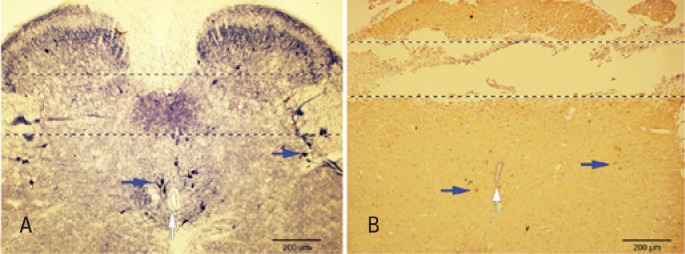
(A). Microphotography of a transversal cryostatic section (40μM) of the spinal cord segment (L6-S1) showing NADPH-diaphorase-positive neurons (blue arrows) and neuropil. Discontinued lines show the site where where the probe was located in the experiments in which the interstice tissue was microdialyzed. It can be noted that the probe position is approximately 200μM dorsally to the central canal (white arrow). (B). Microphotography of a transverse section (6μM) obtained from a paraffin-embedded spinal cord segment (L6-S1) showing positive nNOS immunoreactive neurons (blue arrows) and fibers as well as the tunnel left by the microdialysis probe. Note that the tunnel is approximately 200μM dorsally to the central canal (blue arrow)